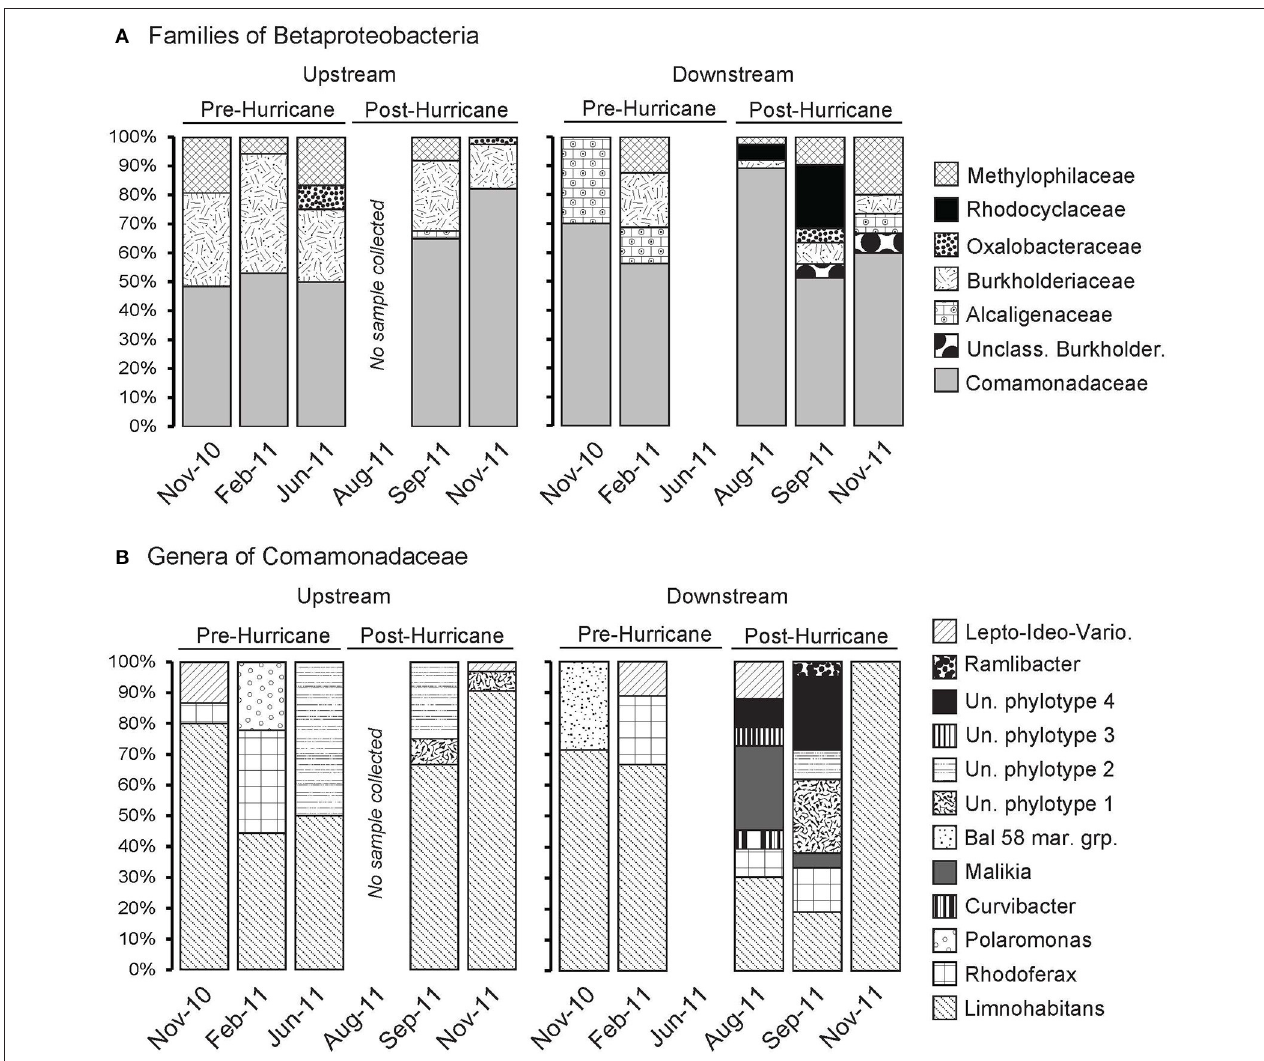
FIGURE 5 | Relative contributions of families within the Betaproteobacteria (A) as well as genera and unassigned phylotypes within Comamonadaceae (B). The identification of the different families, genera and well-defined clusters in Betaproteobacteria was based on constructed phylogenetic trees shown in Figure S2A (families) and Figure S2B (genera and other clusters), their annotation following published taxonomies of betaproteobacterial families and genera. “Un. Phylotype” refers to the Unassigned phylogtypes found within Comamonadaceae